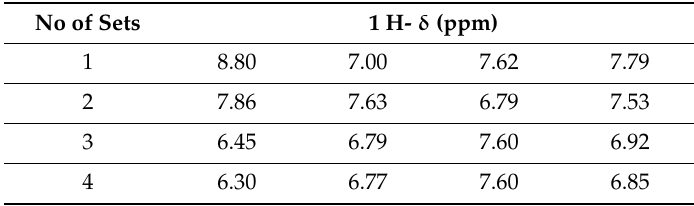
Table 3. Phenylpyridine protons identified from TOCSY